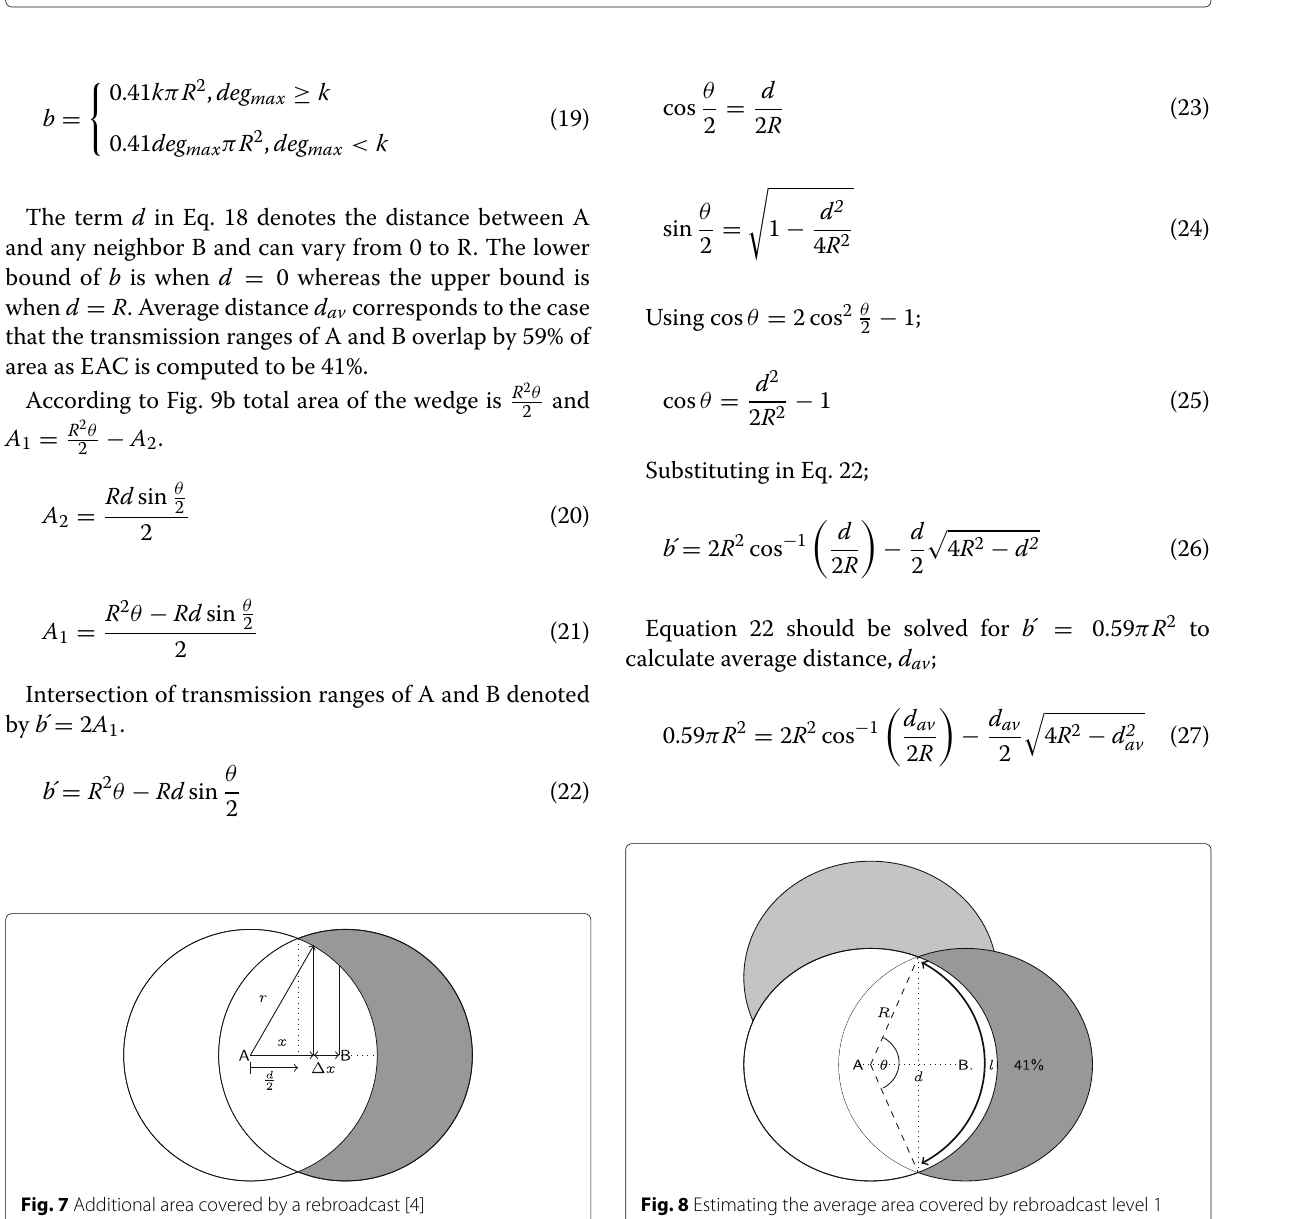
Fig. 6 Geometric estimation of reached nodes at each rebroadcast level. a Illustration of flooding wave. b Water ripple